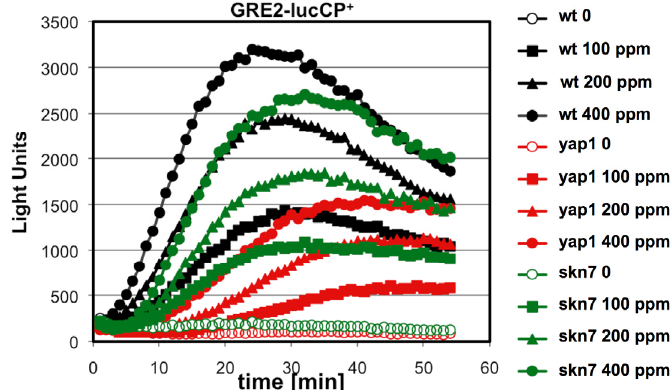
Figure 3. Citrinin activates gene expression via the oxidative stress responsive transcription factors Yap1 and Skn7. A fusion of the stress inducible GRE2 promoter with destabilized luciferase was used as a real time reporter for gene expression. The reporter activity was measured in yeast wild type and yap1 or skn7 mutants upon addition of the indicated concentrations of citrinin. Data shown are mean values from three independent biological samples. SD <